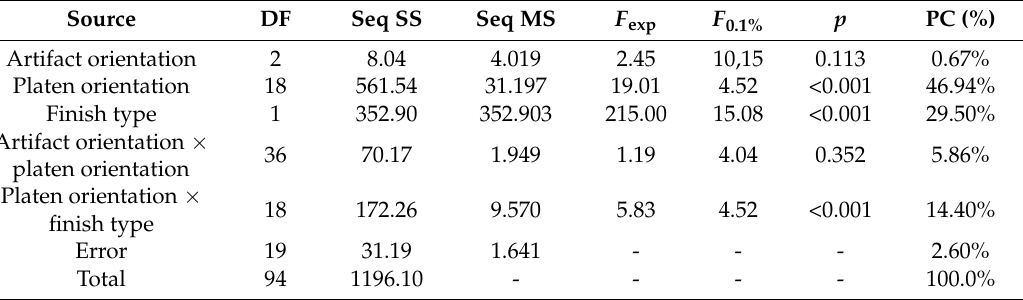
Table 9. The percentage contribution ratio based on